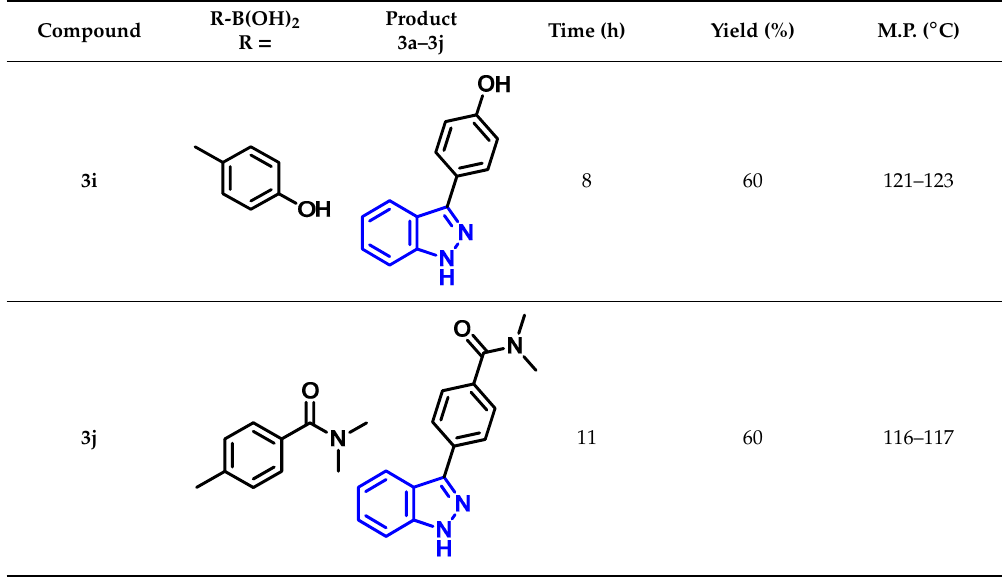
Table 2. Details of the series of compounds 5a–5j.